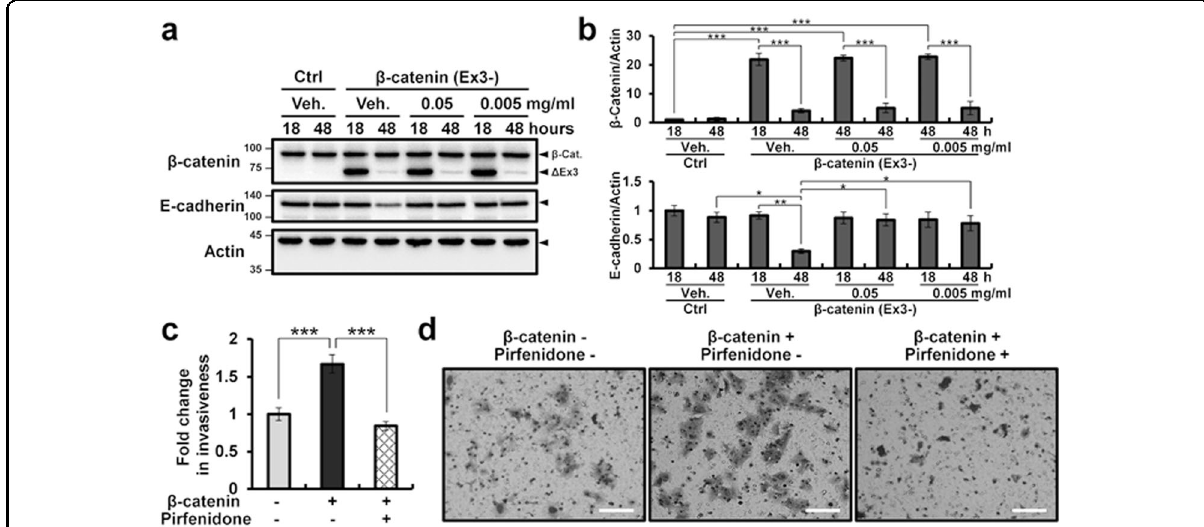
Fig. 6 Decrease in the β -catenin-induced EMT process in Ishikawa cells by inhibition of TGF- β . a Western blot analysis of β -catenin and E- cadherin in control or exon 3-deleted β -catenin vector-transfected Ishikawa cells treated with or without pirfenidone for 18 and 48 h. Actin was used as a sample loading control. b Quanti fi cation of western blot results in the control or exon 3-deleted β -catenin vector-transfected Ishikawa cells treated with or without pirfenidone for 18 and 48 h ( n = 3). c Quanti fi cation of invasion through the Matrigel and transwell membrane control or exon 3-deleted β -catenin vector-transfected Ishikawa cells treated with or without pirfenidone for 48 h ( n = 5). d Representative results of transwell invasion assays of control or exon 3-deleted β -catenin vector-transfected Ishikawa cells treated with or without pirfenidone for 48 h. The results represent the mean ± SEM. * p < 0.05, ** p < 0.01, and *** p < 0.001. Scale bars represent 100 μ